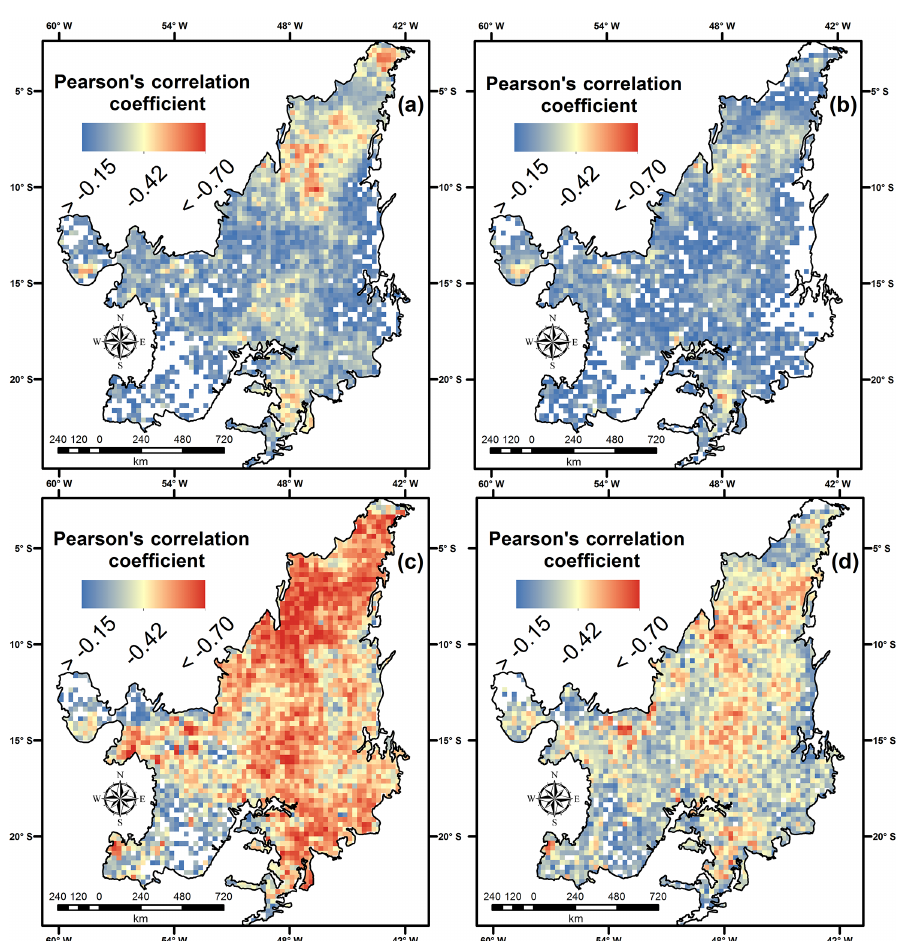
Figure 6. Spatial correlation between (a) monthly total hotspots and monthly average precipitation, (b) monthly total burned area and monthly average precipitation, (c) monthly total hotspots and monthly average VCI and (d) monthly total burned area and monthly average VCI in the Cerrado biome during the 2002–2015 period. Only statistically significant pixels are shown in the